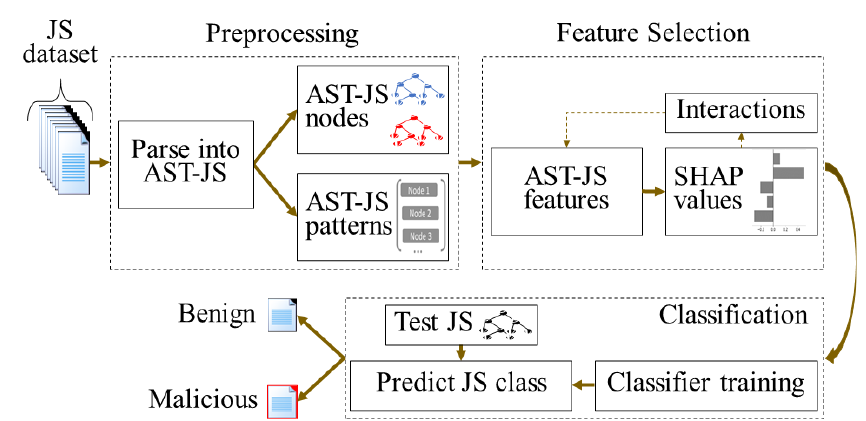
Figure 1. The proposed web-based attacks detection